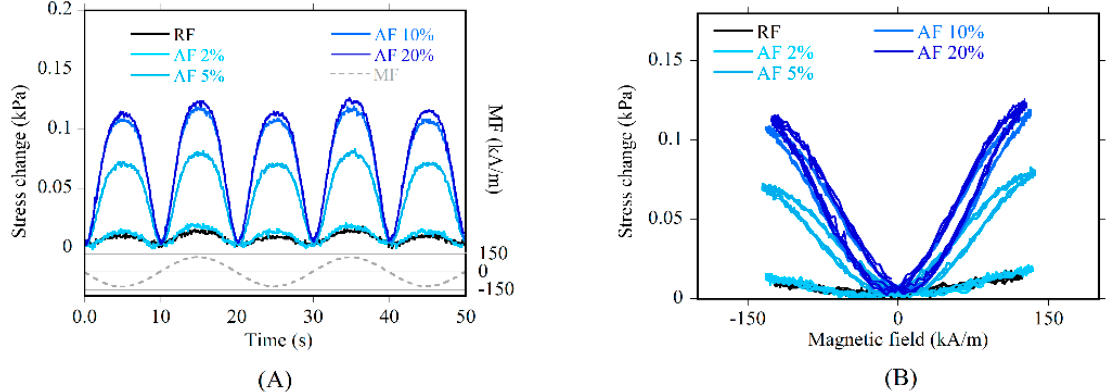
10 of 17 ( C ) Figure 8. Microtomographic reconstructions at different strain levels of three representative sam- ples: ( A ) PU, ( B ) RF, ( C ) AF_189_T0-10. 3.3. Magnetoelastic Behaviour The magnetoelastic characterization shows the smart behavior imparted by linear aggregates. This was performed by measuring the stress change under a sinusoidal MF (amplitude equal to 132 kA/m, frequency 0.05 Hz) at different prestrains (2%, 5%, 10%, 20%). Both the strain and the MF were applied along the foaming direction, which is co- incident with the alignment direction of the aggregates during the foaming process. The stress induced by the MF was combined with the polymer response, and therefore it can be evaluated by subtracting the stress value just before the application of the MF from the actual stress value measured under the MF. The PU did not show any stress change in response to the application of MF, as ex-